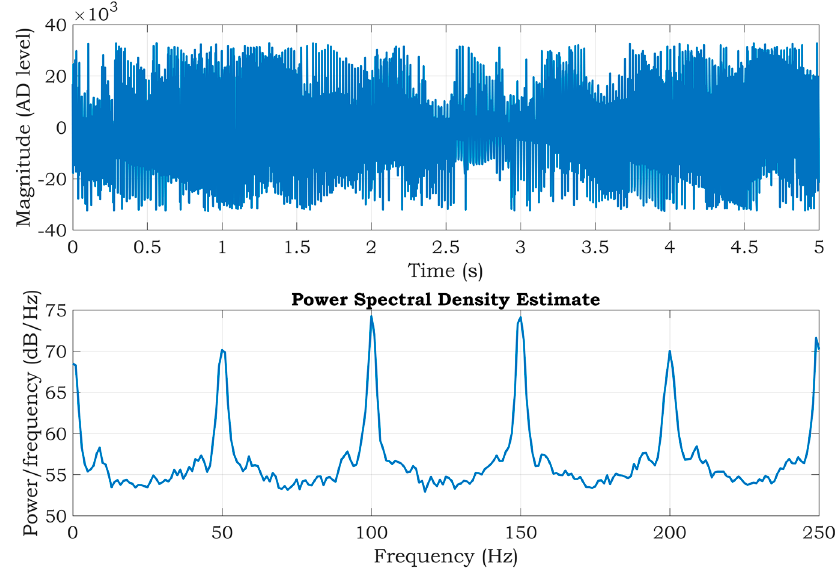
Figure 15. ECG signal measured from a living subject without noise suppression (top), and the corresponding PSD estimate (bottom).